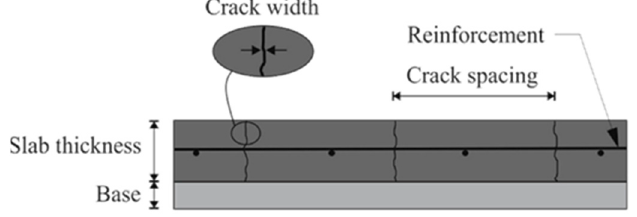
Figure 1. Structure of CRCP and main influencing factors.